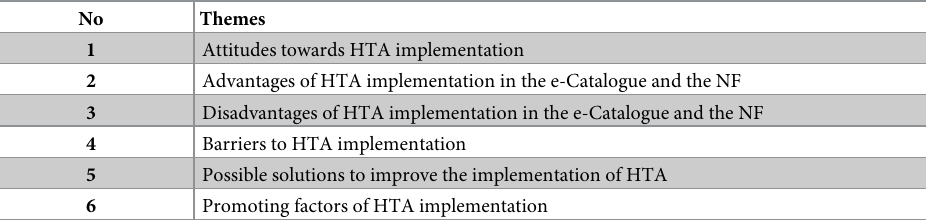
Table 1. List of